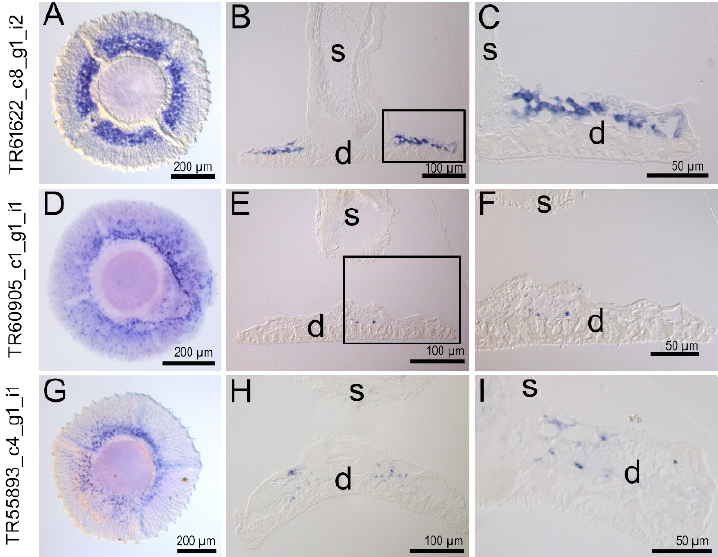
Figure A4. In situ hybridization screen panel 4. ( A – K ) Ventral view onto the tube foot disc. The distribution of the in situ hybridization signal (blue) is very weak and present only in a small subset of disc cells. Therefore, these transcripts represent proteins of unknown function. Scale bar, 200 µm, inset C, D and E, 25 µm.